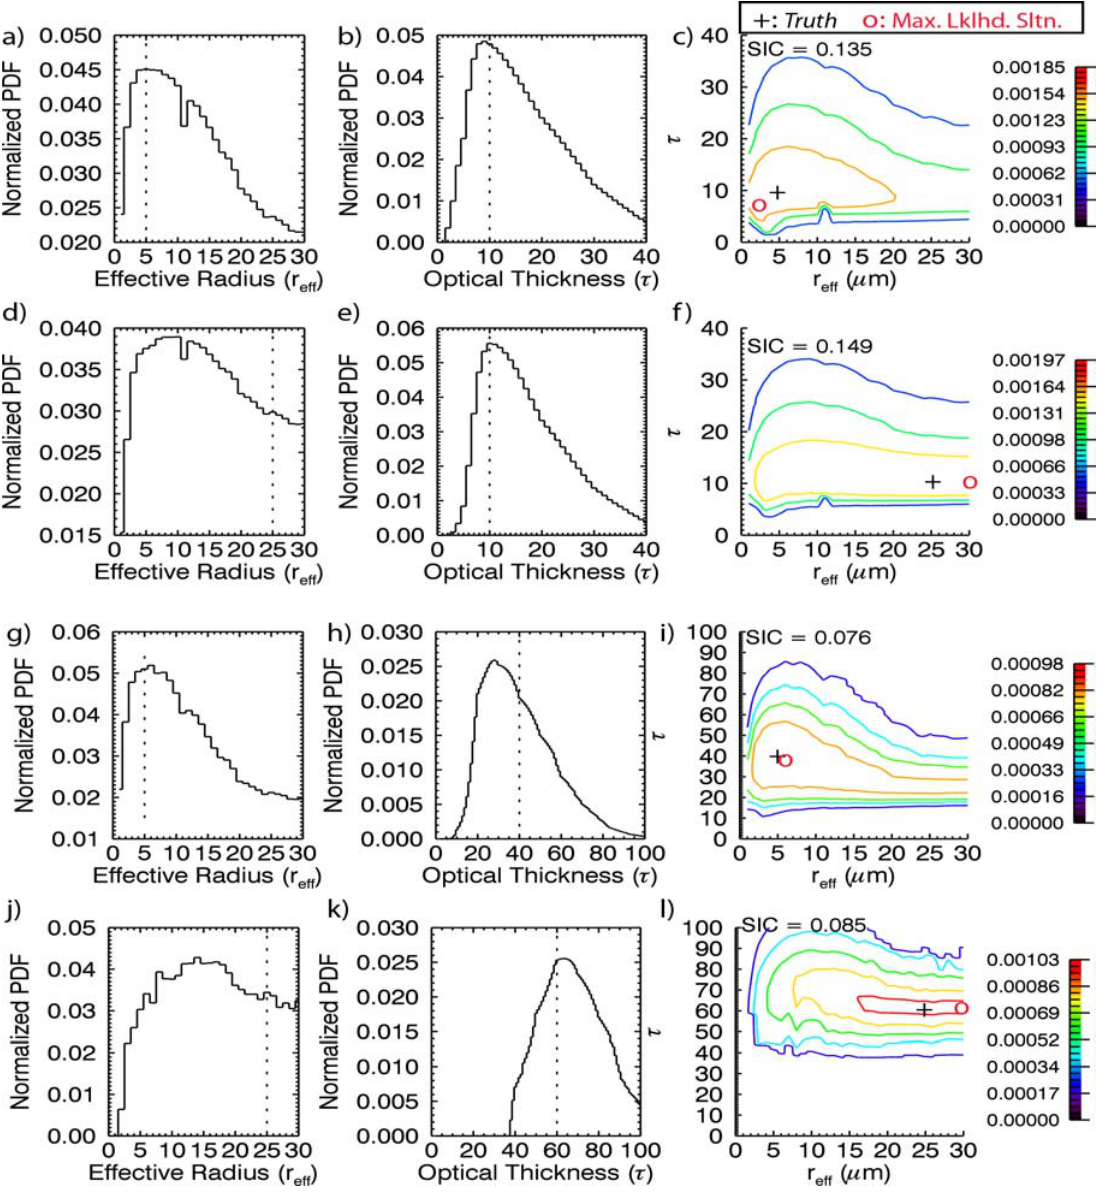
Figure 8. 1-dimension marginal pdfs in optical thickness and effective radius and the joint posterior pdfs for true ( a–c ) τ , r = 10, 5 μ m, ( d–f ) τ , r = 10, 25 μ m, ( g–i ) τ , r = 40, 5 μ m, e e e and ( j–l ) τ , r = 60, 25 μ m. True values in τ , r are indicated by vertical dashed lines. e e Calculations shown are for μ = 0.866, +3% systematic measurement error, and variable 0 surface albedo from bare soil to purely vegetated surface types. In joint posterior pdf plots, red circles denote the maximum likelihood solution and the black plus symbol the true τ and r . Results shown are a subset of those in Figure 7 (for slope method; right column) and e demonstrate that the mean statistics in the marginal pdfs are not equivalent to the maximum likelihood solution in the joint posterior pdf when the distributions are